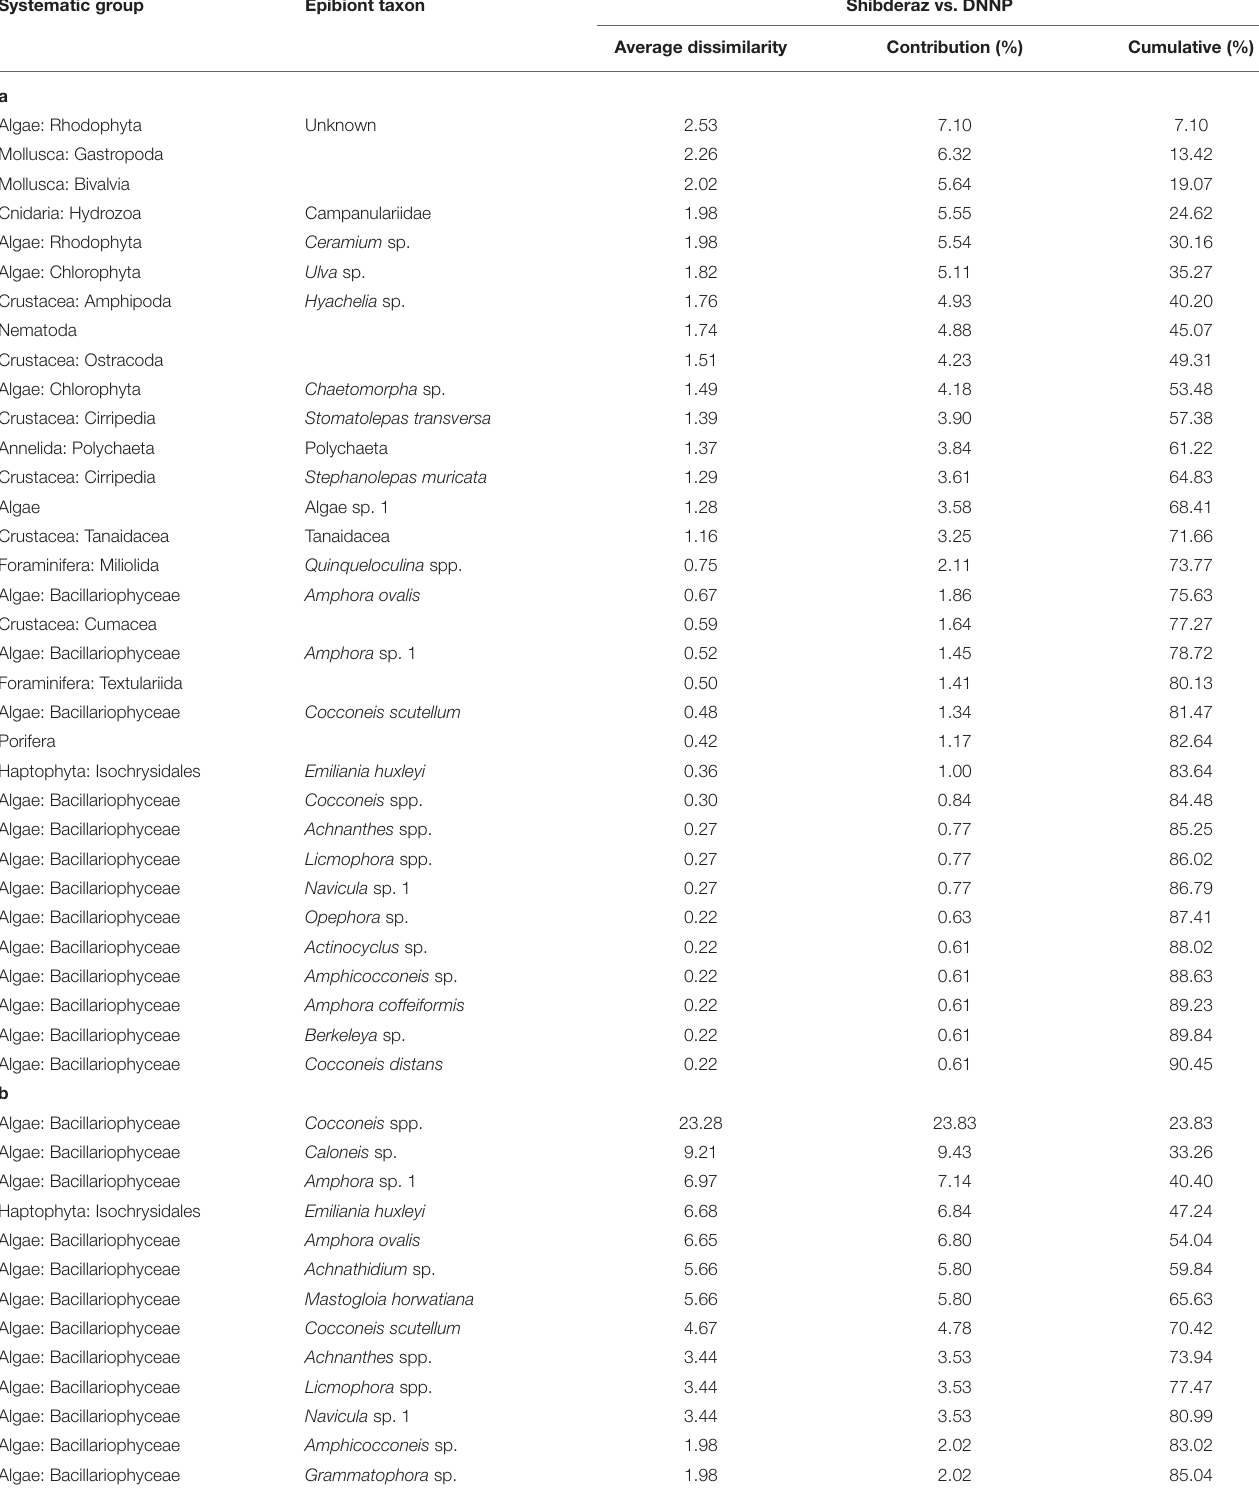
TABLE 3 | Results of the SIMPER procedure to identify the relative contribution of each epibiont taxa to the dissimilarity between the epibiont assemblages of hawksbills ( Eretmochelys imbricata ) nesting on Shibderaz (Qeshm Island) and Dayyer-Nakhiloo National Park (DNNP; Bushehr) beaches, Iran: (a) all epibionts, (b) micro-epibionts and (c)